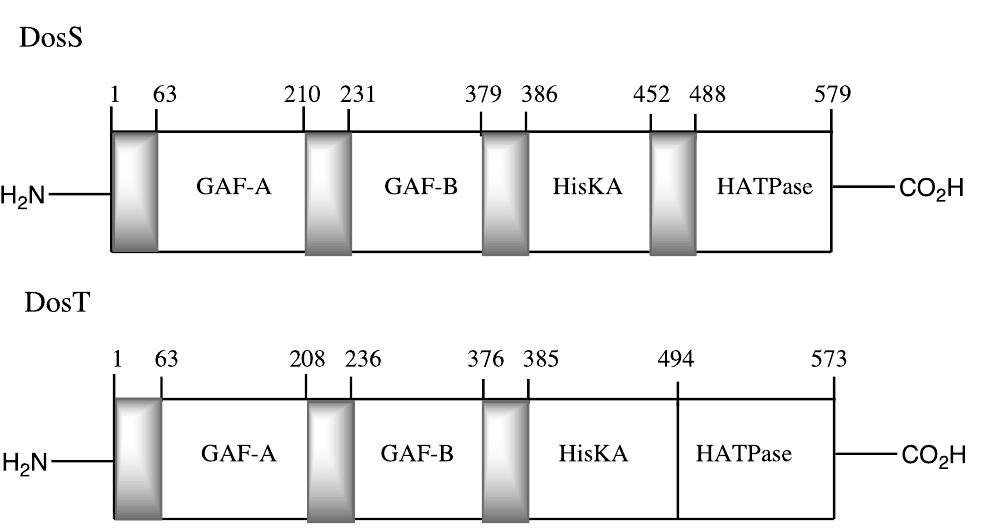
Figure 1. Domain structure of Mtb DosS [28] and DosT